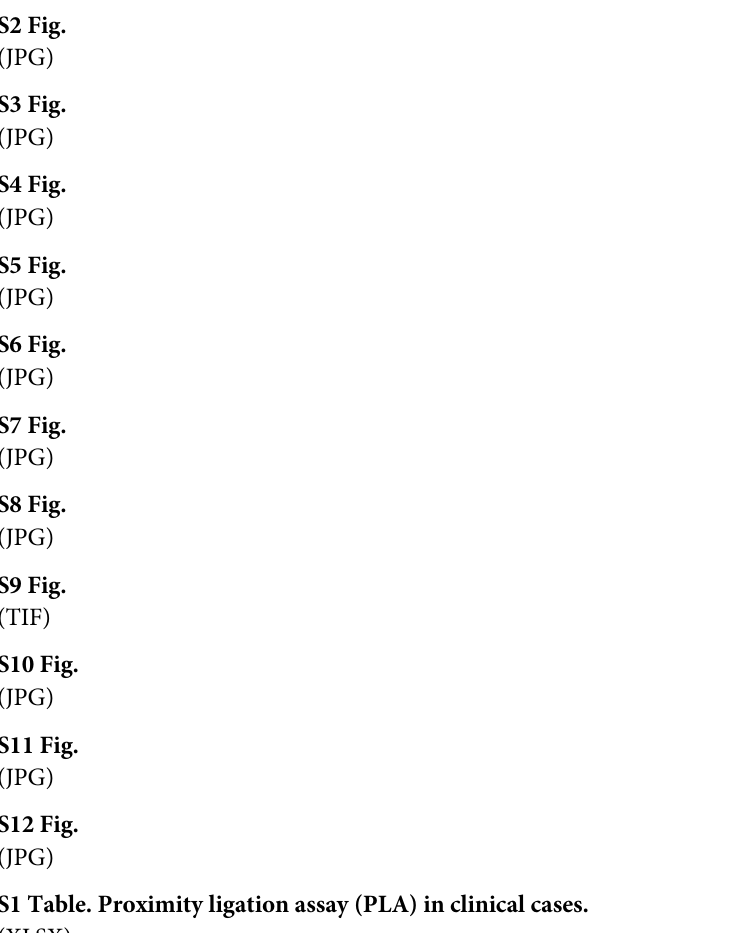
S1 Table. Proximity ligation assay (PLA) in clinical cases.